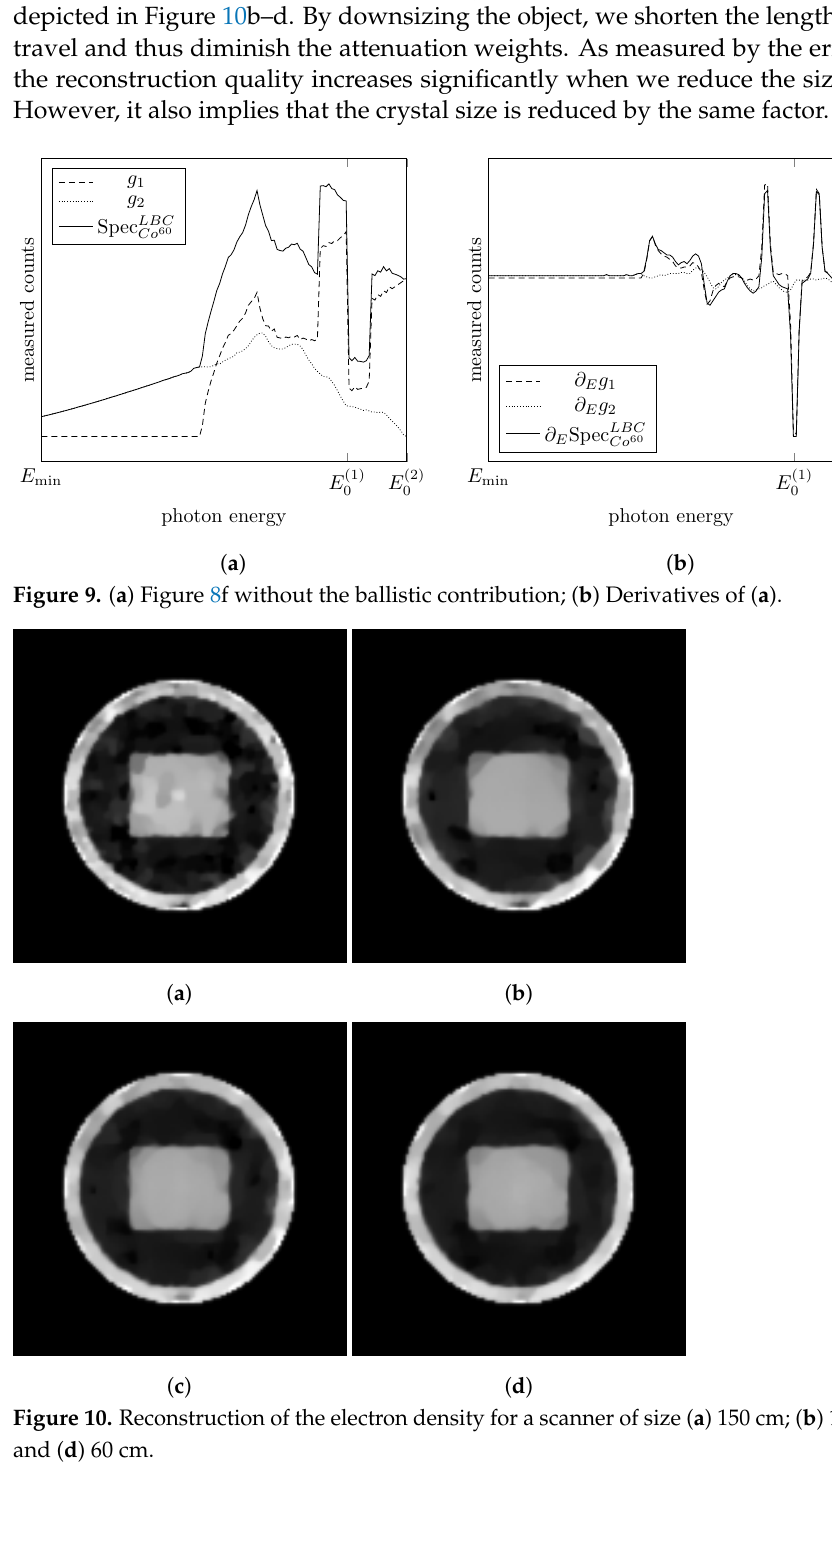
Figure 10. Reconstruction of the electron density for a scanner of size ( a ) 150 cm; ( b ) 100 cm; ( c ) 75 cm and ( d ) 60